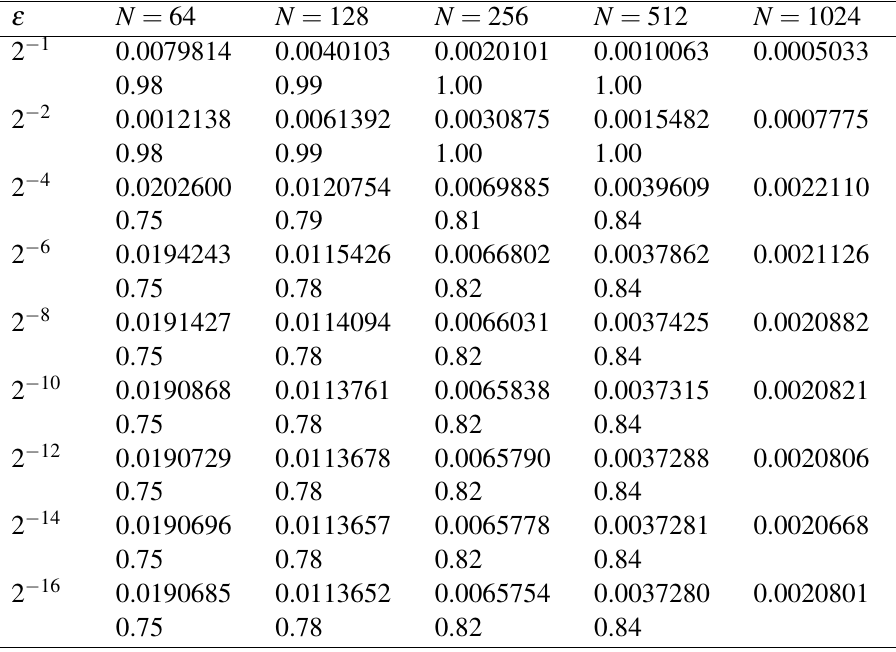
Table 2 Maximum errors and rates of convergence on ω N ,